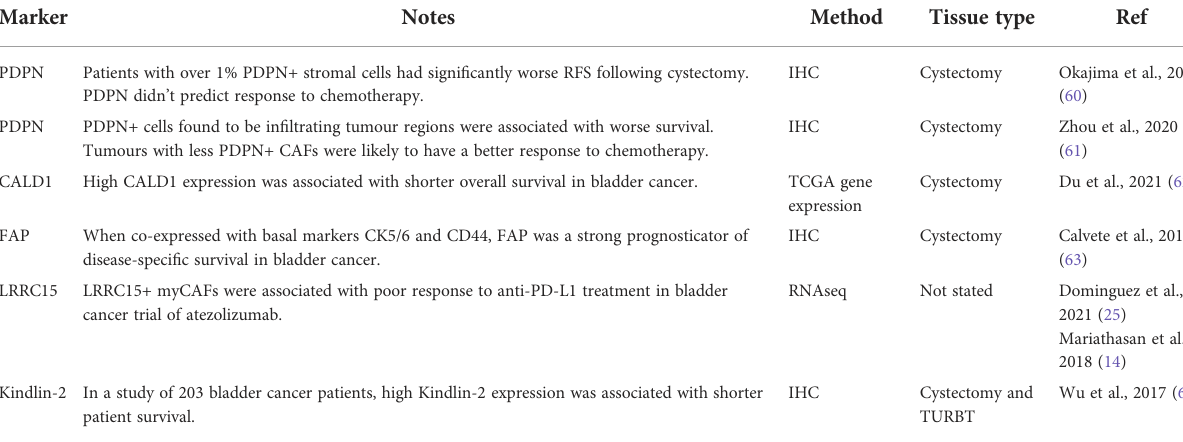
TABLE 1 An overview of research studies that have evaluated individual markers of CAFs in bladder cancer.